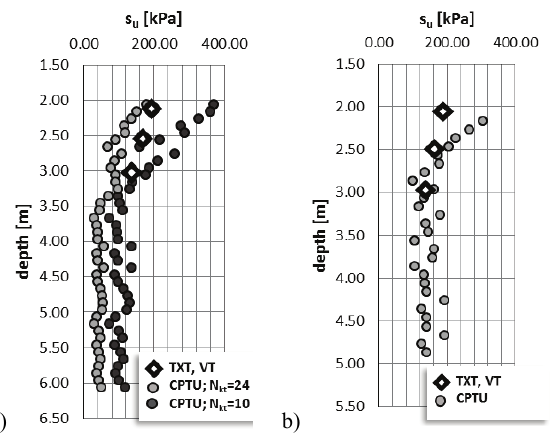
Fig. 6. A comparison of shear strength values from CPTU with results of reference tests